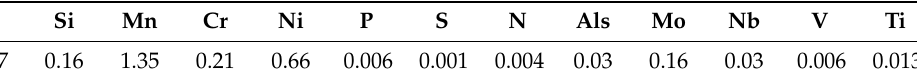
Table 1. Chemical composition of EH47 steel (wt%).